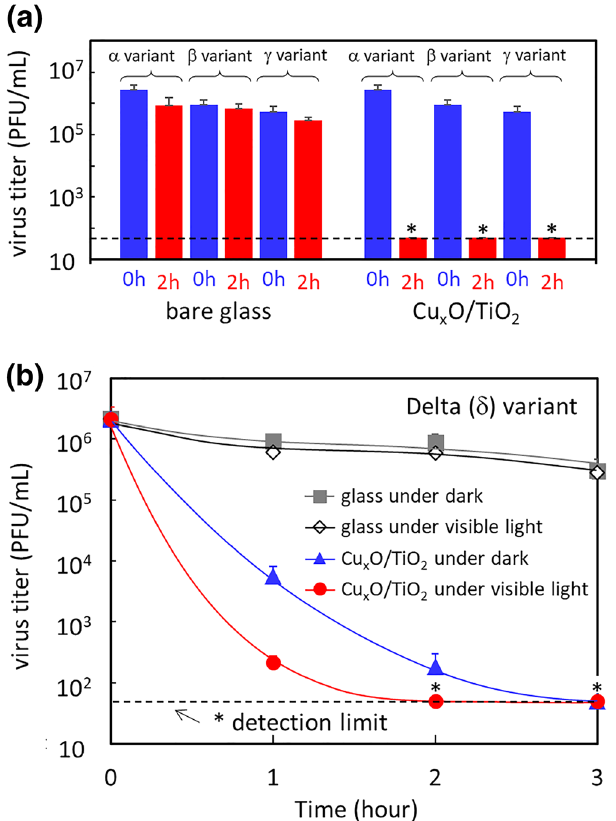
Figure 3. Inactivation of various types of variants. ( a ) changes of virus titer of Alfa (α), Beta (β), and Gamma (γ) variants under 0 and 2 h of visible light irradiation and ( b ) changes of virus titer of Delta (δ) variant. Visible light irradiation was conducted using a white fluorescence bulb passed through a UV cutoff filter with the light intensity of 1000 lx. Asterisk marks (*) and dashed lines in the panels indicate detection limit of